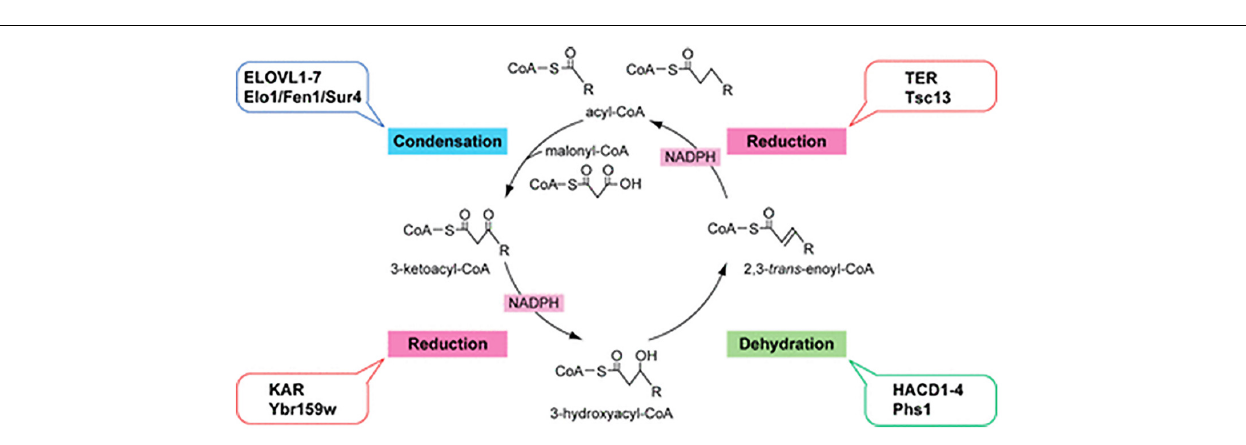
18:2) ( Figure 1 ). Strikingly, the skin of Elovl4 − / − mice is